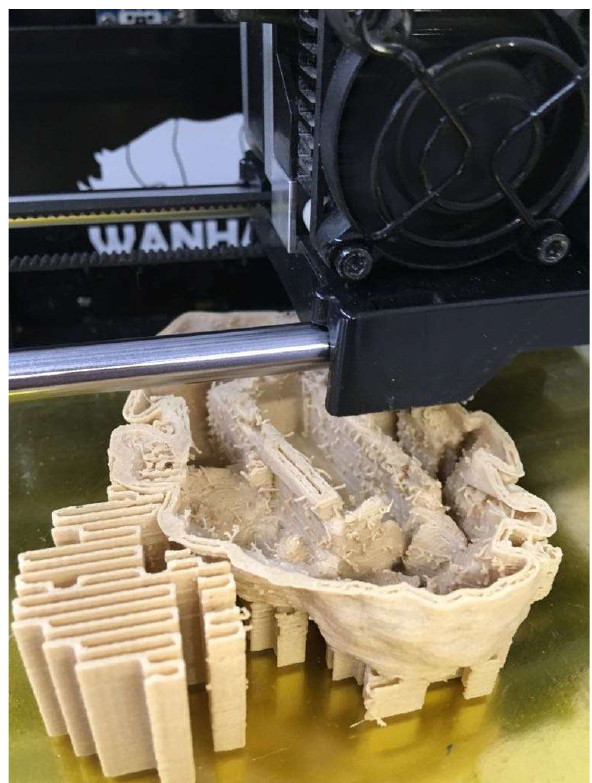
Figure 13. Sarcophagous chamber. 3D model. Scanner Faro focus 3D and SCENE software.